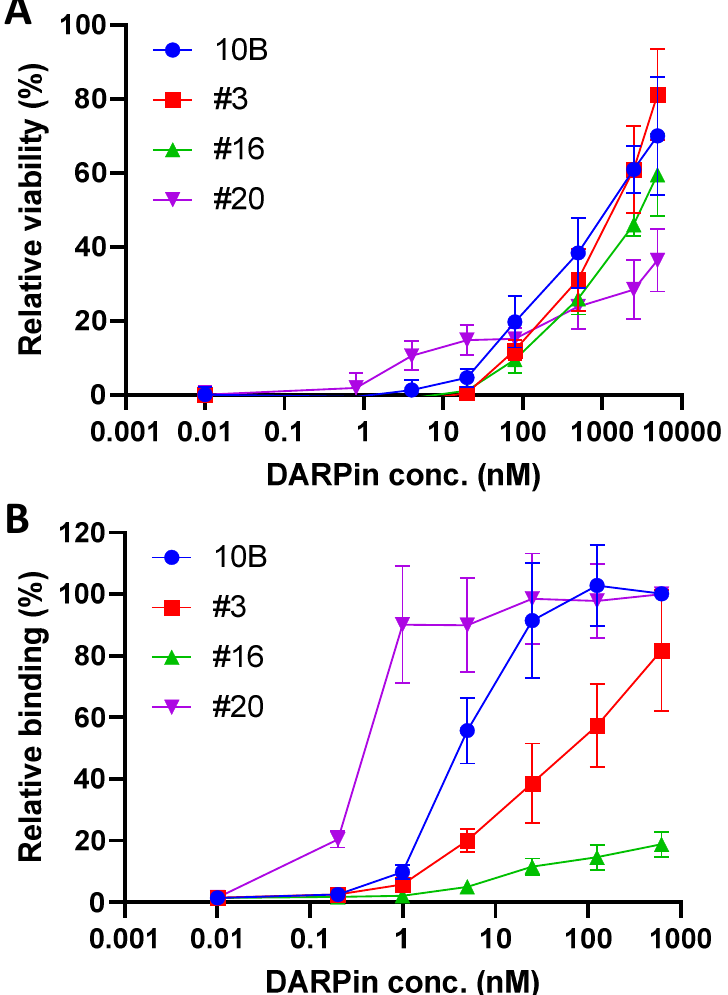
Figure 1. Characterization of parental anti-Stx2 DARPins discovered from a phage-displayed naïve DARPin library. ( A ) Monomeric DARPins protected Vero E6 cells from Stx2a-induced cytopathic effect. Each well contains 1.5 × 10 3 Vero cells, 5 pg/mL (or 57 fM) Stx2a, and the appropriately diluted DARPin. Error bars represent the standard deviation of two independent experiments performed in duplicate. ( B ) Relative binding of monomeric DARPins to Stx2a, determined using ELISA. Error bars represent the standard deviation of two independent experiments.